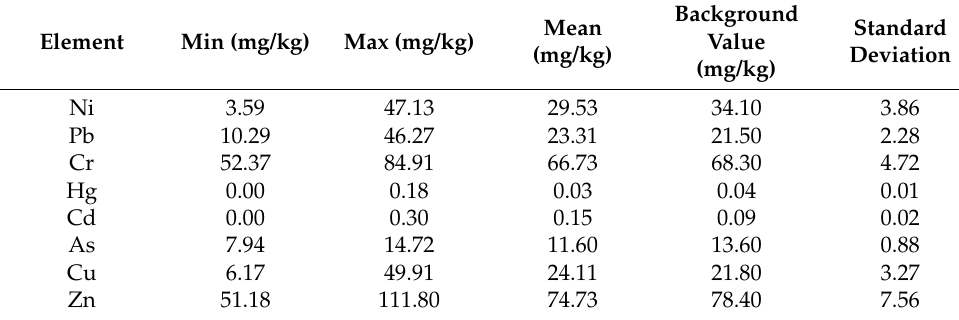
Figure 5. The spatial distribution of heavy metals in Huanghua (( a – g ) correspond to the elements of Ni, Pb, Cr, Cd, As, Cu and Zn, respectively).